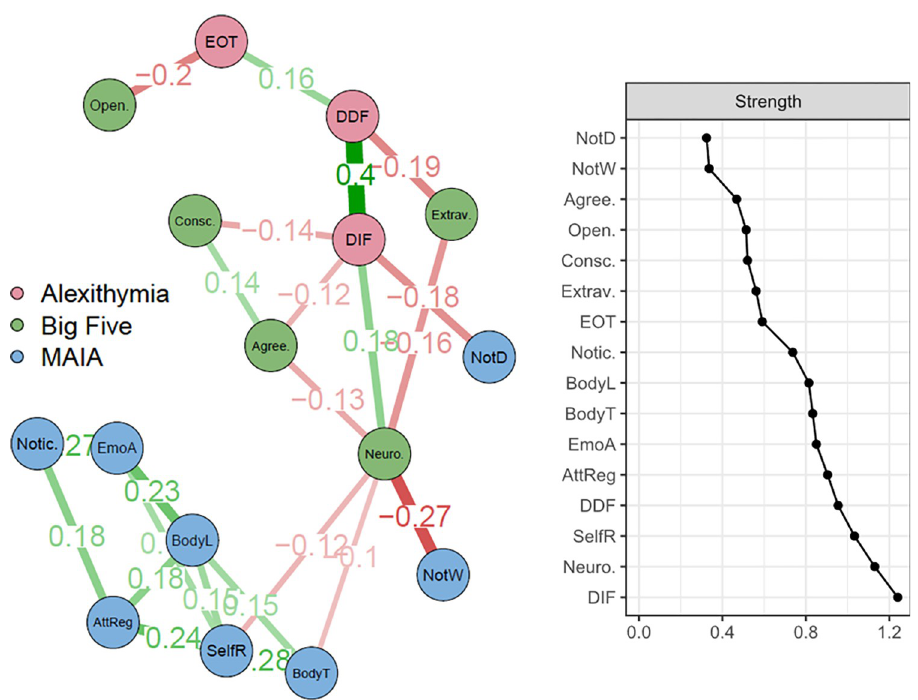
Fig 1. Exploratory partial correlation network for alexithymia, interoception and the Five-Factor Model of personality. Nodes represent TAS-20 subscales (i.e. Difficulty Identifying Feelings [DIF], Difficulty Describing Feelings [DDF], Externally Oriented Thinking [EOT]), Big Five factors (i.e. Neuroticism [Neuro.], Extraversion [Extrav.], Openness [Open.], Agreeableness [Agree.], Conscientiousness [Consc.]), and MAIA subscales (Noticing [Notic.], Not-Distracting [NotD], Not-Worrying [NotW], Attention Regulation [AttReg], Emotional Awareness [EmoA], Self-Regulation [SelfR], Body Listening [BodyL], Body Trusting [BodyT]). Only connections higher than 0.1 are displayed in the figure; the plot for strength centrality metrics is on the